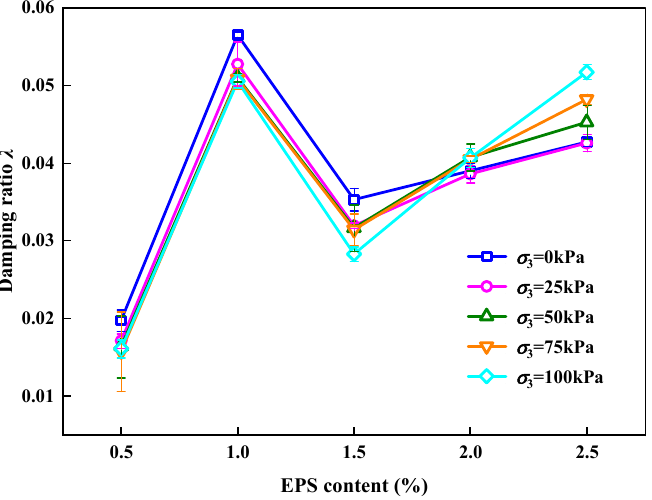
Figure 9. Relationship between EC and λ .